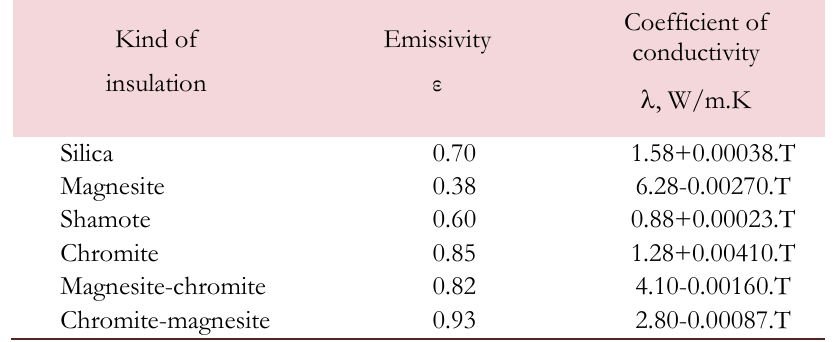
Table 1: Thermophysical characteristics of insulating material.[5]